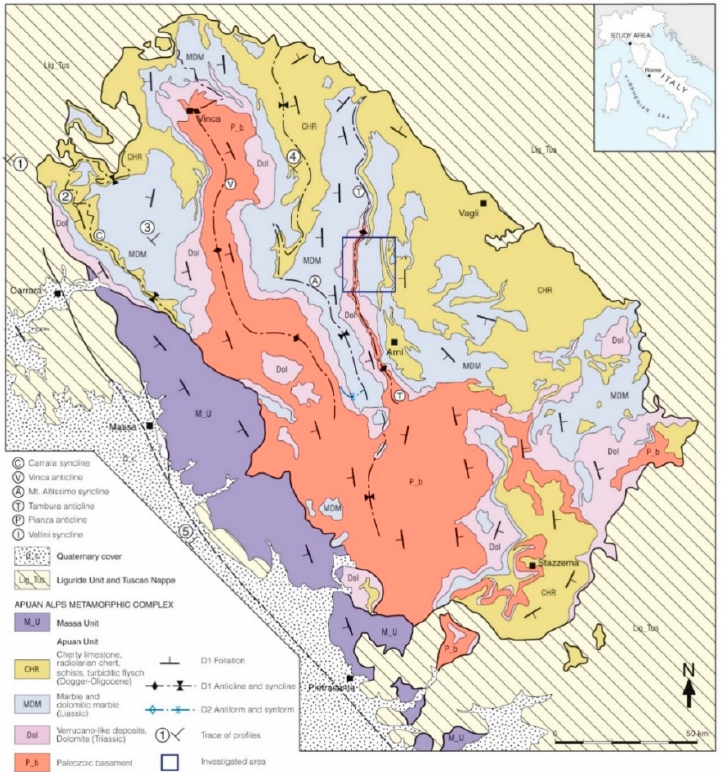
Figure 1. Geological sketch map of the Apuan Alps. The location of the quarry under study is highlighted by a blue rectangle (modified after [35]).